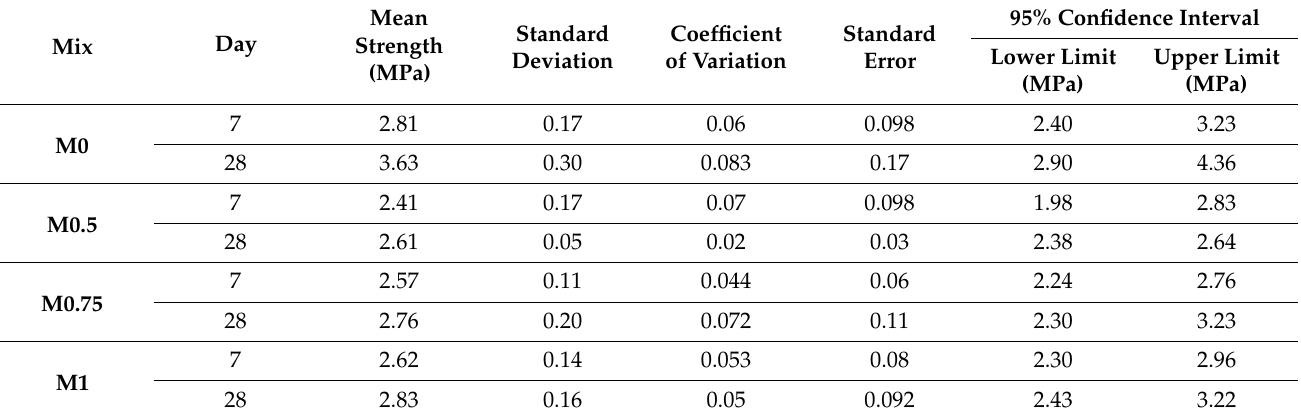
Table 8. Tensile strength test results summary.